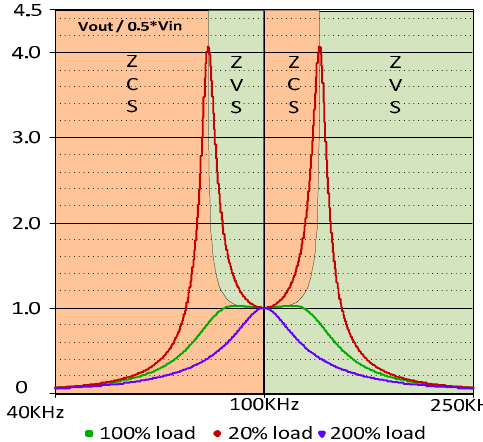
Figure 2. Voltage gain characteristic with operating regions.